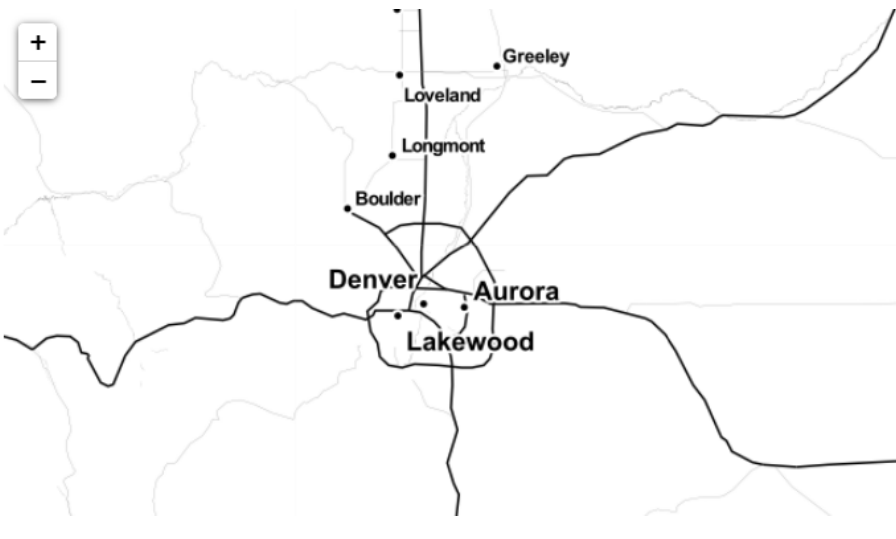
Figure 9. Base layer of the heatmap.